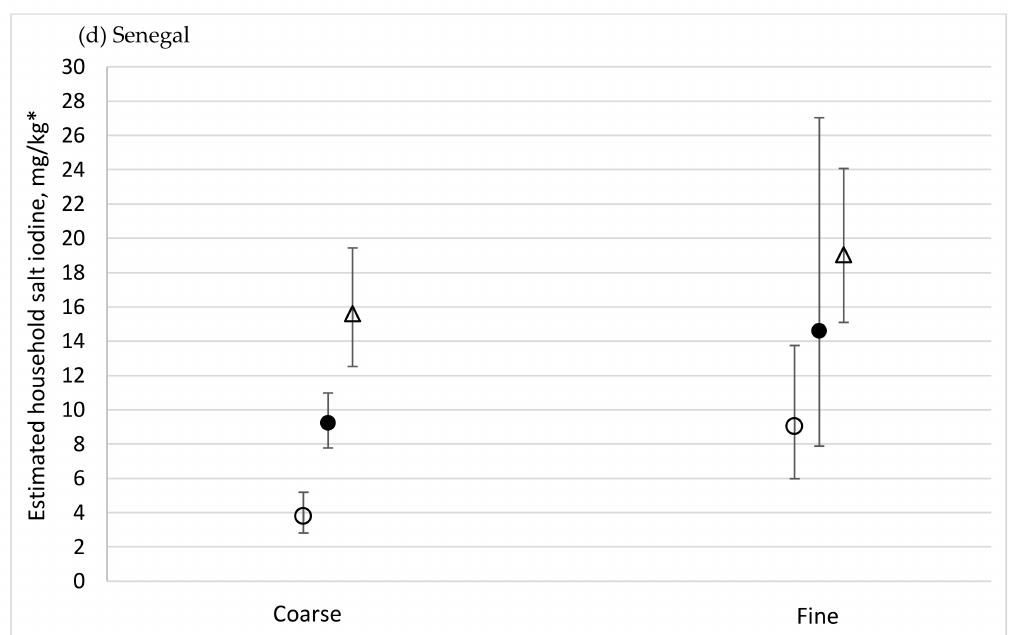
Figure 1. Multiple regression analysis including interaction with strata, to estimate household salt iodine (mg/kg) according to salt grain type in ( a ) Bangladesh,